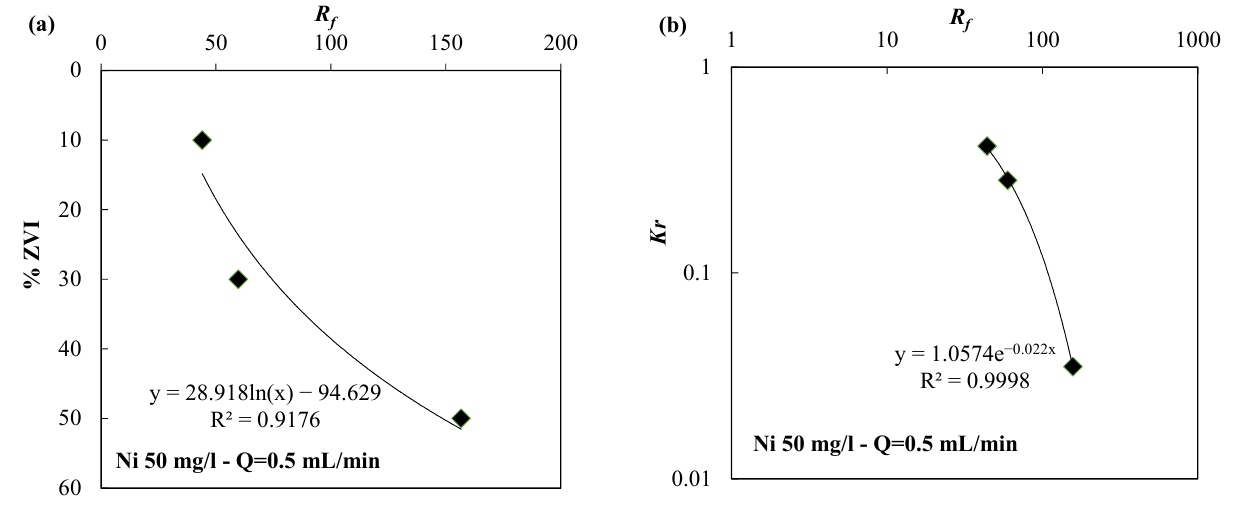
Figure 9. ( a ) % ZVI vs. R f and ( b ) Kr vs. R f for the ZVI/lapillus granular mixture permeated with a solution of nickel 50 mg/L at a flow rate equal to 0.5 mL/min.